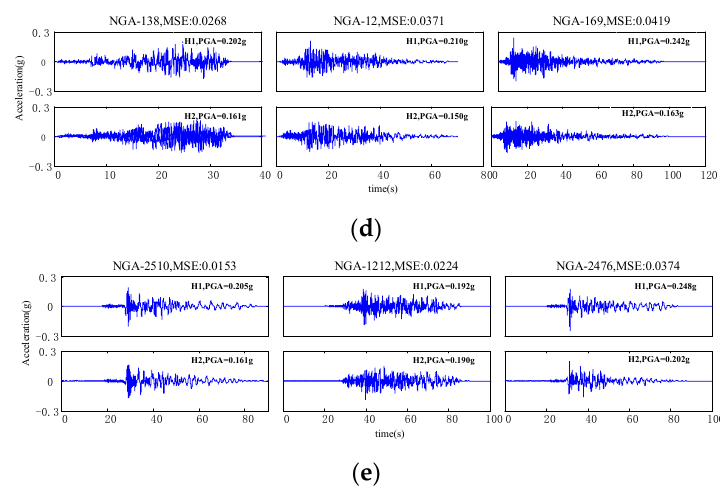
Figure 5. Earthquake histories for different sites. ( a ) Earthquake histories of Site A. ( b ) Earthquake histories of site B. ( c ) Earthquake histories of site C. ( d ) Earthquake histories of site D. ( e ) Earthquake histories of site E.